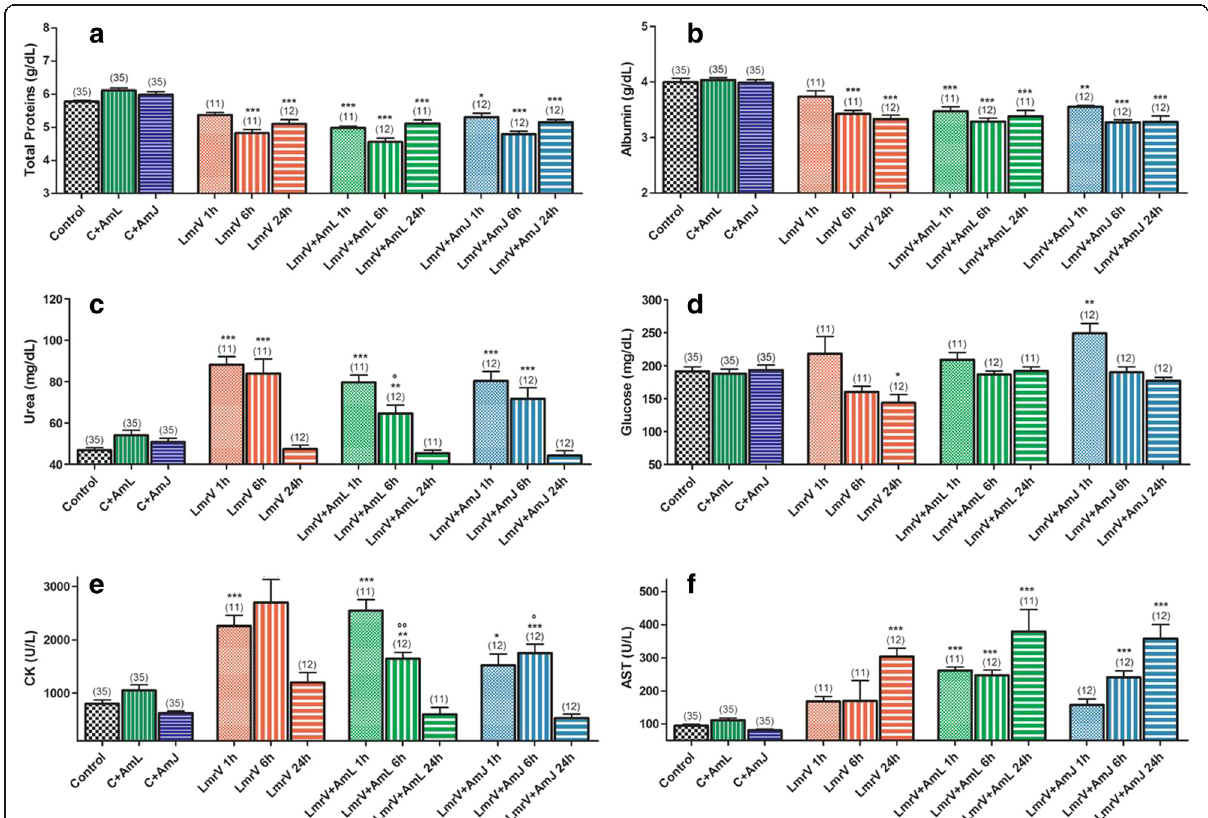
Fig. 1 a Concentration of total proteins, b albumin, c urea, d glucose, e CK and f AST in the serum of male Wistar rats injected with 3 mg of Lachesis muta rhombeata venom, at 1, 6 and 24 h after envenomation (LmrV) and with their respective treatments with aqueous extract of Annona muricata L. leaves (LmrV+AmL) or Annona muricata L. juice (LmrV+AmJ). The numbers above the columns represent the number of animals used in each test. *** p <0.001, ** p <0.01, * p 0.05 compared to control group. p <0.05, °° p <0.01 compared with the envenomation group